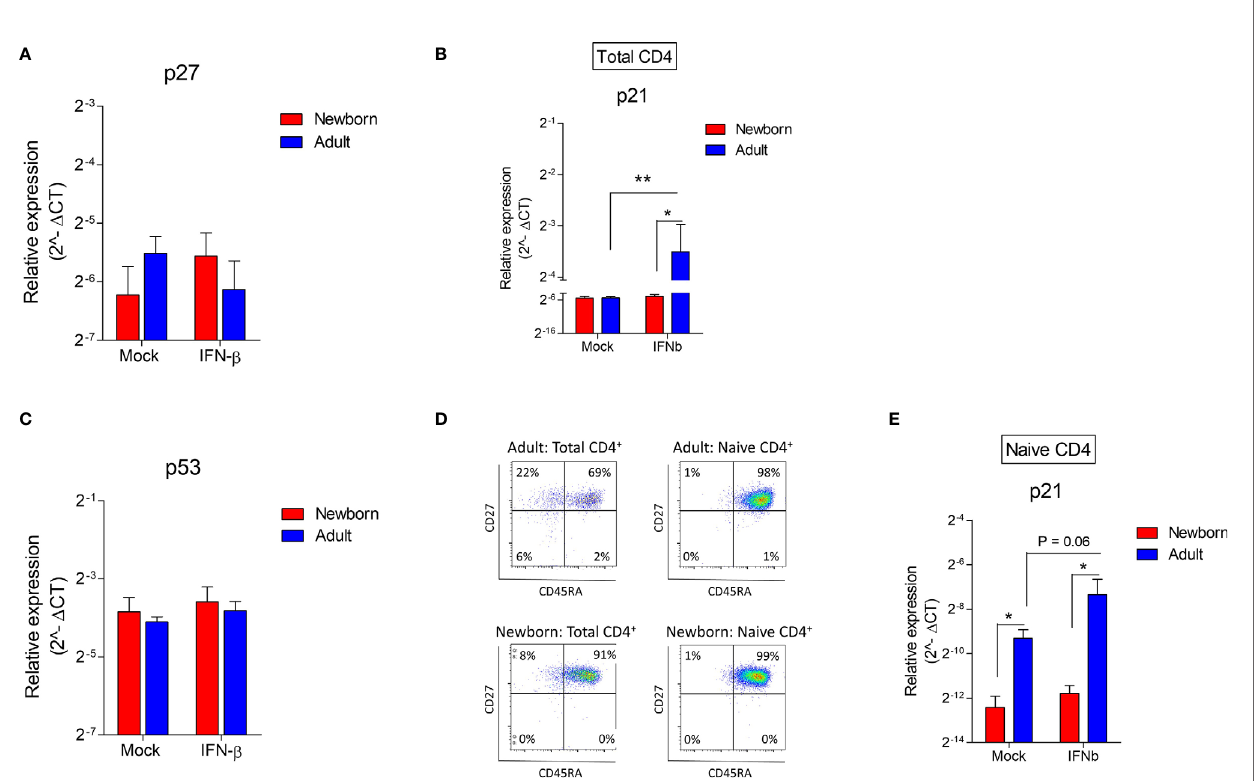
FIGURE 4 | Contrary to adults, newborn naïve CD4 + T cells lack the induction of p21 after exposure to IFN- b . (A – C) Expression of p27, p21 and p35 after exposure of newborn and adult CD4 + T cells to IFN- b for 24h. (N=4-8). (D) Subset analysis after isolation of total and naïve CD4 + T cells in newborns and adults. (E) Expression of p21 after exposure of newborn and adult naïve CD4 + T cells. (N=4). Data are presented as means ± SEM. * = P <0.05. ** = P